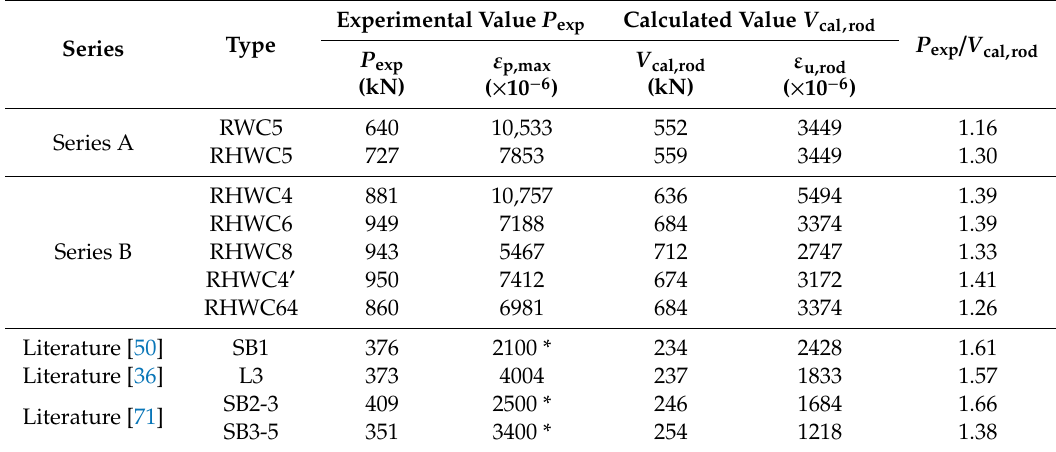
Table 9. Comparison between calculated value V cal,rod results and the corresponding experimental